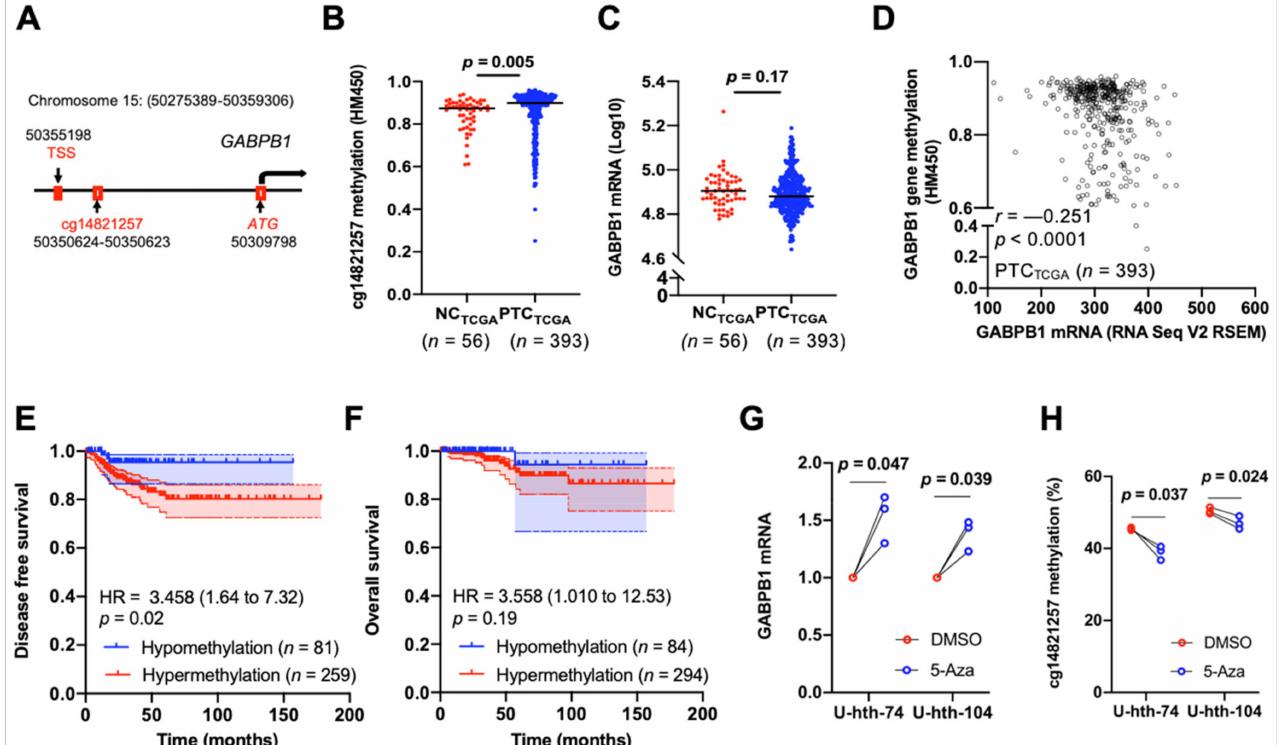
Figure 4. GABPB1 promoter hypermethylation contributes to the downregulation of GABPB1 ex- pression and predicts shorter disease-free survival in thyroid cancer. Analyses of GABPB1 promoter methylation density, gene expression, and survival in PTC TCGA were performed. Cellular experi- ments using a DNA methylation inhibitor were performed to verify the causal relationship between GABPB1 promoter methylation and gene expression. ( A – D ) Identification of cg14821257 at the GABPB1 promoter as the predominant CpG affecting GABPB1 expression. ( B , C ) Significantly in- creased cg14821257 methylation in PTC TCGA tumors as compared to adjacent non-cancerous thyroid tissues (NC TCGA ), but no significant difference for GABPB1 expression. ( D ) The inverse correlation between methylation of cg14821257 and GABPB1 mRNA levels. ( E , F ) Hypermethylation of the GABPB1 promoter was significantly associated with shorter disease-free survival but not with overall survival. ( G ) Upregulation of GABPB1 expression in U-hth-74 and U-hth-104 cells treated with the DNA methylation inhibitor 5-Aza. ( H ) Reduced cg14821257 methylation in U-hth-74 and U-hth-104 cells treated with the DNA methylation inhibitor 5-Aza. cg14821257 methylation was determined using